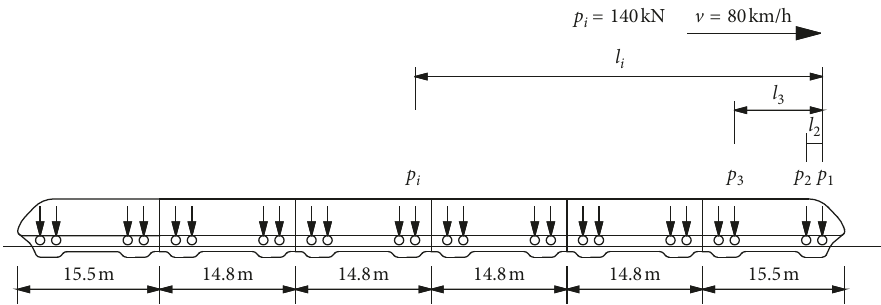
Figure 20: Simplified loading model of a straddle-type monorail traffic running cable-stayed bridge.